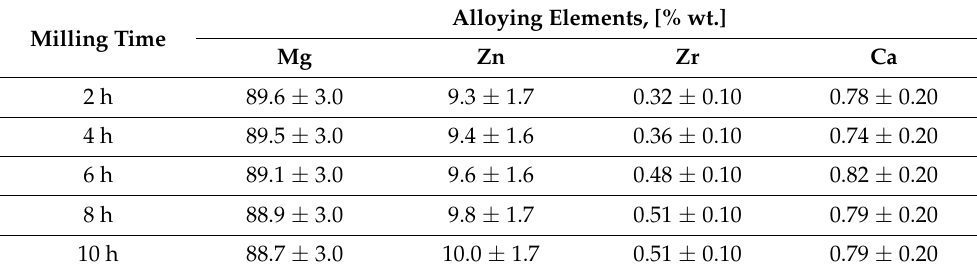
Table 3. Average chemical compositions of the powder-alloy obtained by EDS analysis for all applied variants of the mechanical alloying process. Milling Time